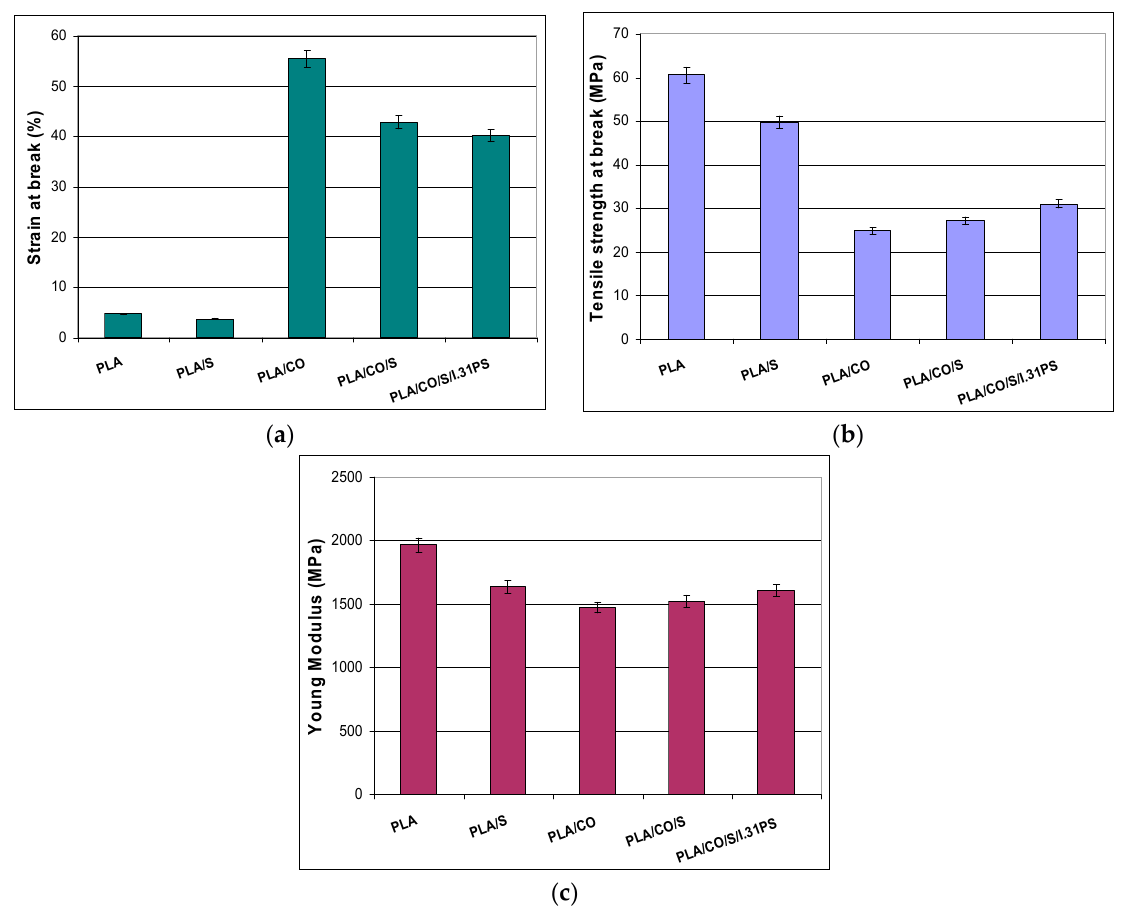
Figure 6. Mechanical properties of the neat PLA and the developed biocomposites: elongation at break ( a ), tensile strength at break ( b ), Young modulus ( c ).